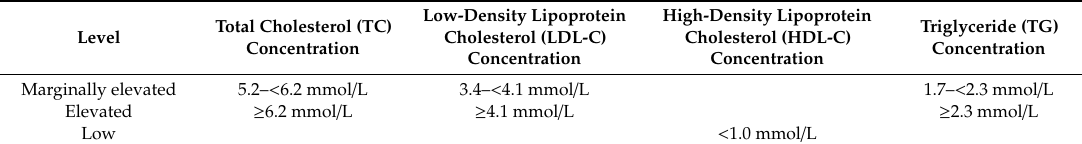
Table 2. Appropriate levels of blood lipids and abnormal stratification standards in Chinese primary arteriosclerotic cardiovascular disease (ASCVD) prevention